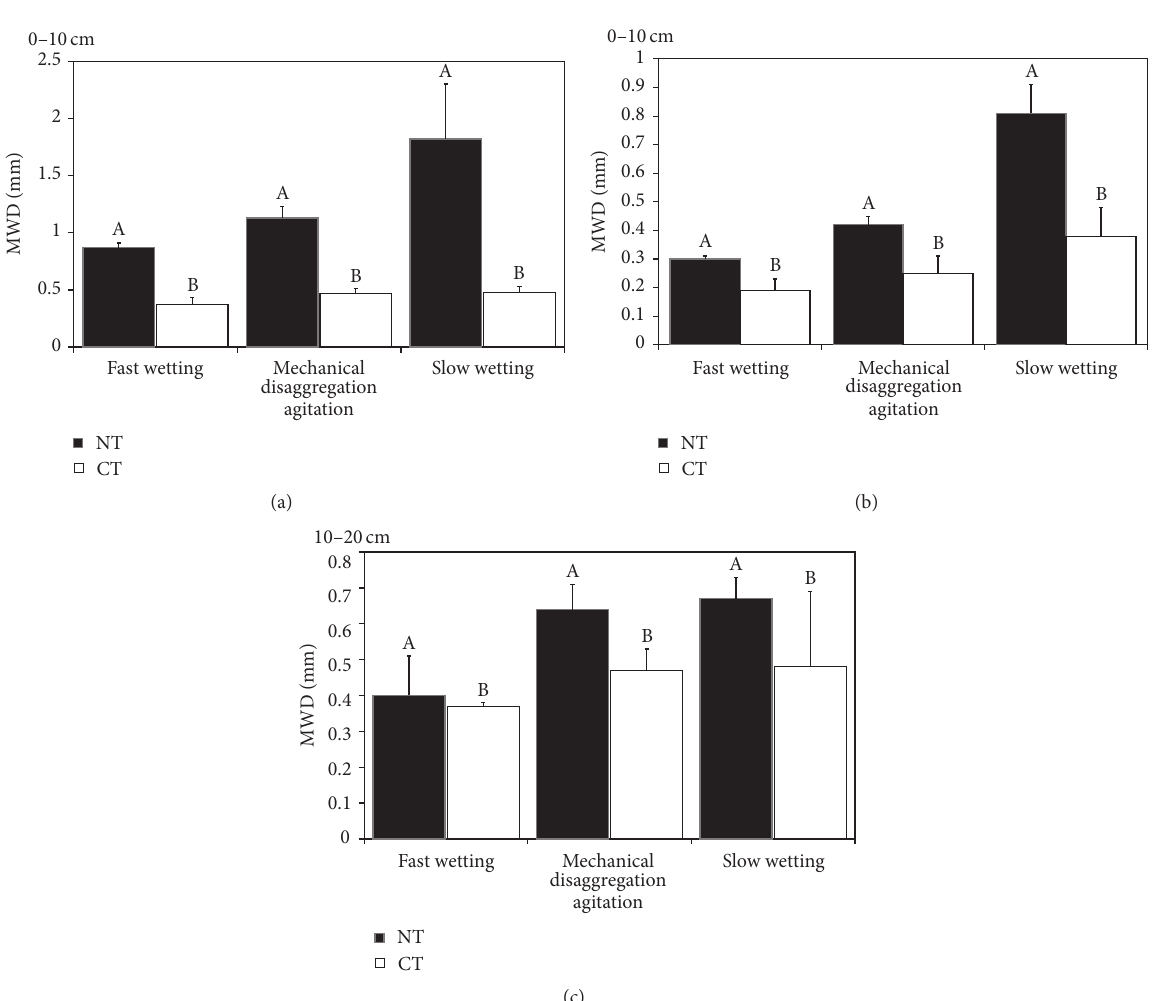
Figure 3: Effect of tillage treatments on structural stability at soil surface for both sits located in Morocco. (a) Mean weight diameter (MWD) for each test of structural stability for the 1st site at 0–10cm of depth; (b and c) mean weight diameter for 2nd site. (b) At 0–10 cm of depth; (c) at 10–20 cm of depth. Bars represent standard deviation, the difference letters above the column show significant difference between no tillage (NT) and conventional tillage (CT) practices.